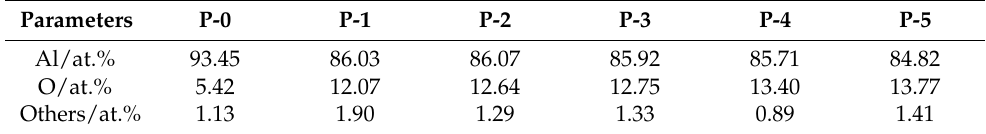
Table 7. The measurement results of the sample surfaces’ chemical composition.